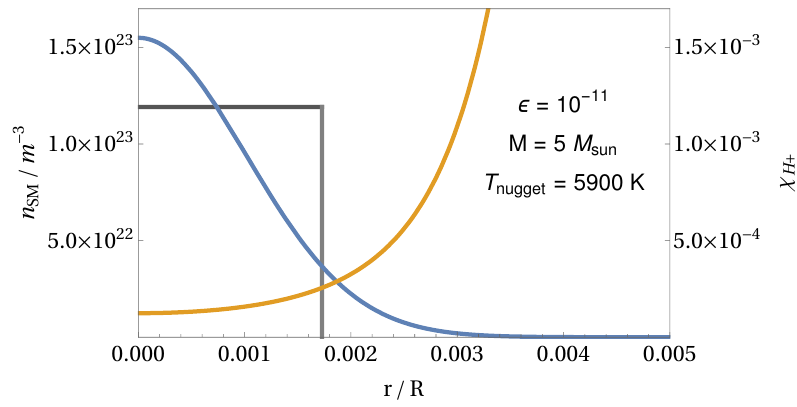
Figure 4 . SM nugget density pro(cid:12)le for a benchmark Mirror Star. In grey we show the pro(cid:12)le one would obtain by assuming the nugget has constant density, with a radius given by the virial theorem, as we assume in the more simpli(cid:12)ed calculation of [104]. For di(cid:11)erent values of (cid:15) , the shape of the pro(cid:12)le is essentially the same, its width scaling with T 1 = 2 . In orange we show the ionization nugget fraction of hydrogen (which dominates the free electron density); for the majority of the mass of the nugget the variation in the level of ionization is modest, while it increases in the outer regions. The optical depth due to free-free absorption depends only on the total density of free electrons, which strictly decreases from the centre of the nugget outwards and vanishes at larger